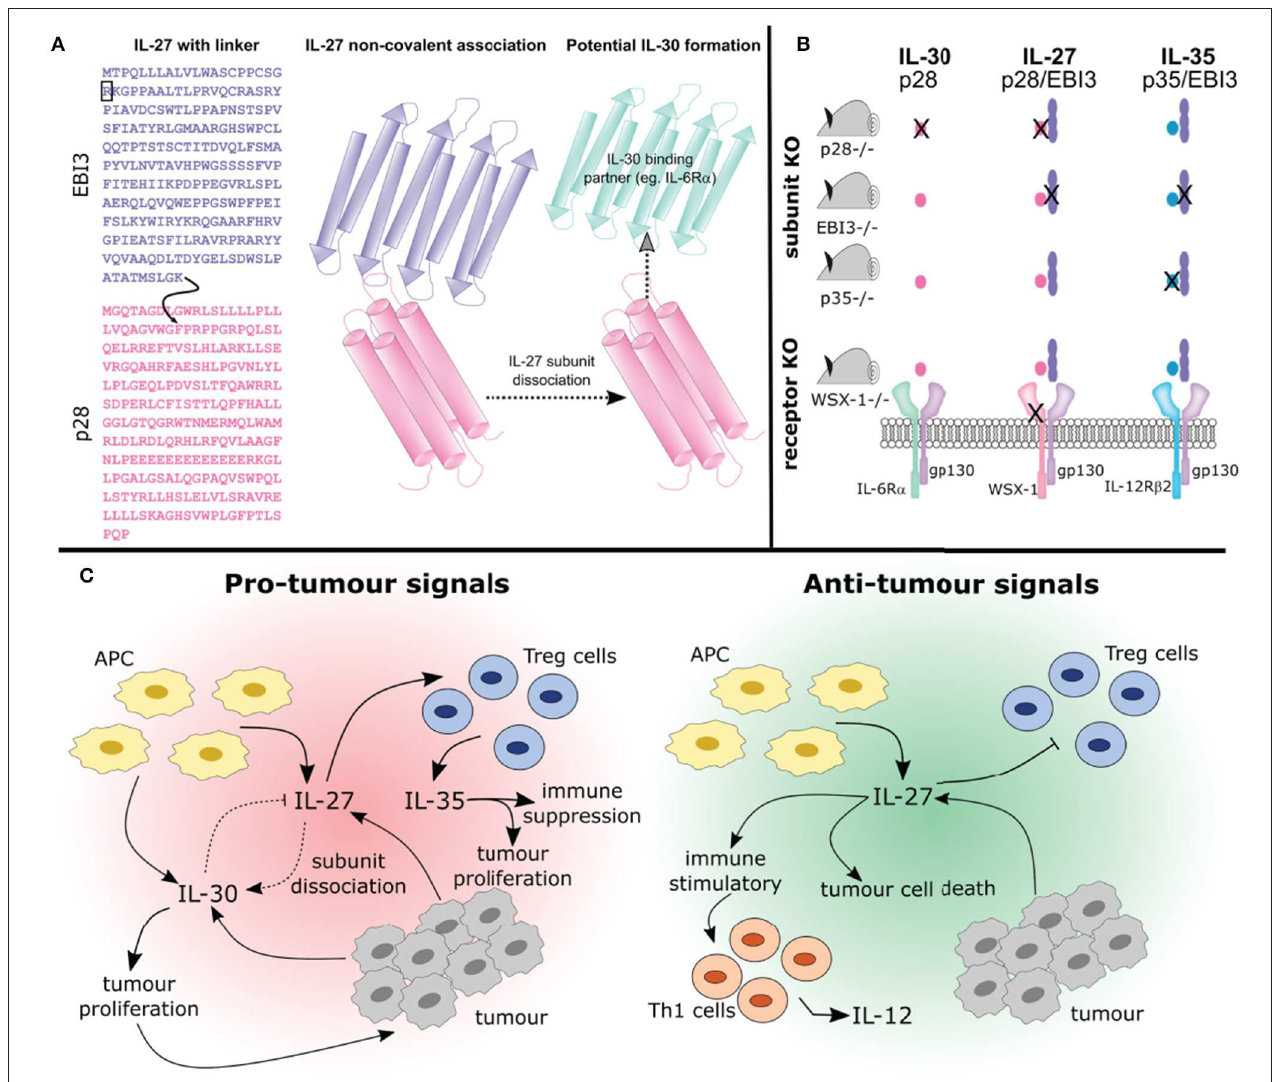
FIGURE 3 | Studying the interplay between IL-27, IL-30, and IL-35. (A) The synthesis of IL-27 as a purified recombinant protein or transduced expression vector varies. Both of these forms of IL-27 are available in two formats: (1) containing a flexible amino acid linker sequence (indicated by the curved black arrow), that joins the EBI3 subunit lacking its signal sequence (indicated by the black box) to phenylalanine 29, after the signal sequence of p28 ( A ; left) or (2) the two subunits co-expressed which associate non-covalently ( A ; middle). Thus, engineered IL-27 may differ from its endogenously expressed counterpart whereby the flexible amino acid linker prevents the possibility of subunit dissociation. Furthermore, whether non-covalently associated IL-27 subunits can dissociate to form IL-30 (i.e., the p28 subunit) or if they associate with another binding partner is not known ( A ; right). (B) Studying the functions of cytokines using knockout mice is complex and the outcomes should be carefully considered. Using p28 knockout mice will result in IL-30 and IL-27 elimination, whereas knockout of p35 eliminates IL-35 and IL-12 (not depicted). Knockout of EBI3 removes both IL-27 and IL-35 (IL-39 is also removed, not shown). Using a WSX-1 receptor chain knockout will prevent IL-27 signaling and may prevent signaling of IL-30. Additionally, IL-35 signaling on B cells will be inhibited (not shown). (C) How these cytokines interact will influence tumor development. The pleiotropic effects of IL-27 produced by APCs can be seen here. IL-27 can promote differentiation of Treg cells which secrete IL-35 resulting in immune suppression and tumor development. Alternatively IL-27 can prevent Treg development and promote anti-cancer Th1 cell development. Importantly, IL-27 may undergo subunit dissociation giving rise to the pro-tumor cytokine IL-30, or can directly act on cancer cells resulting in apoptosis. Overall, the complex relationships between IL-27, IL-30, and IL-35 need to be considered when discussing their potential role in cancer